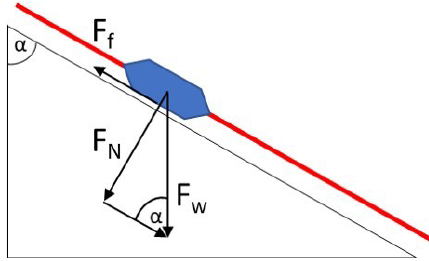
Figure 2. Static friction force F f and normal force F N applying on a sucker rod contact point (nylon centralizer) as a function of the weight force F w and the borehole inclination 90 ◦ − α .